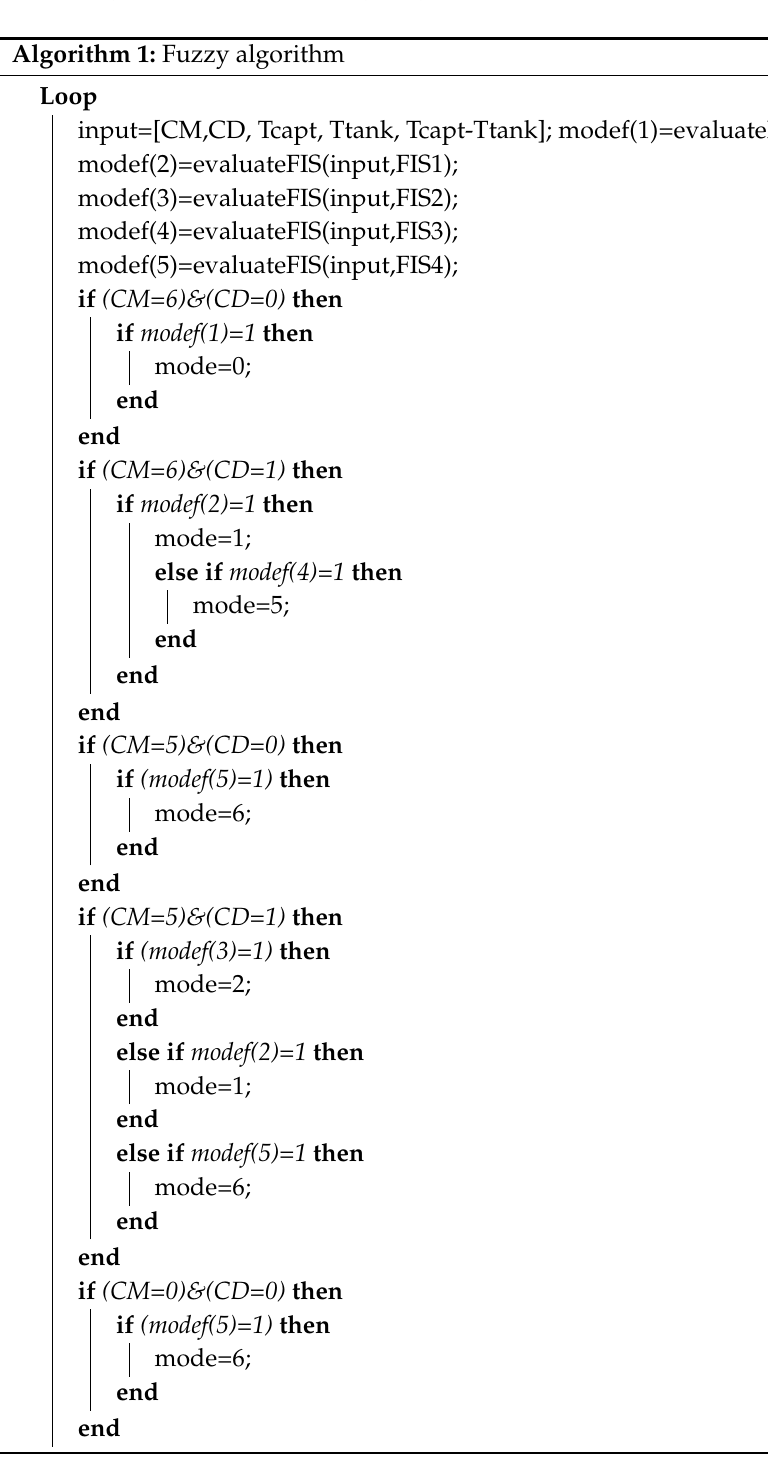
Algorithm 1: Fuzzy algorithm